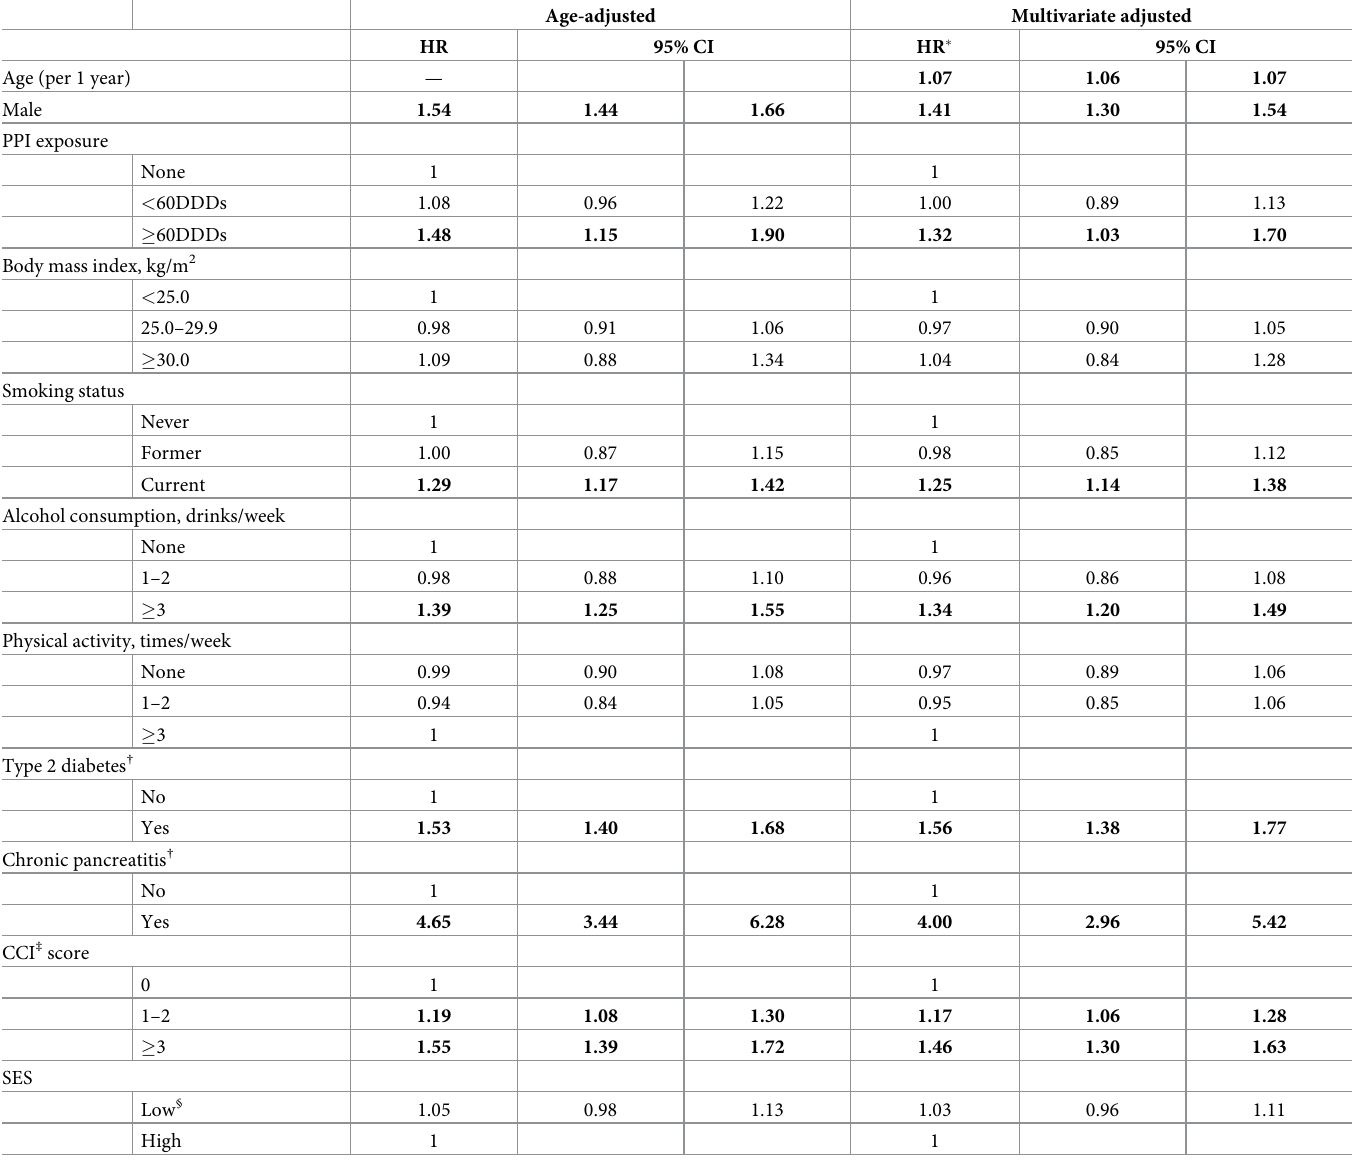
Table 2. Adjusted HRs and 95% CIs for pancreatic cancer associated with PPI and covariates.